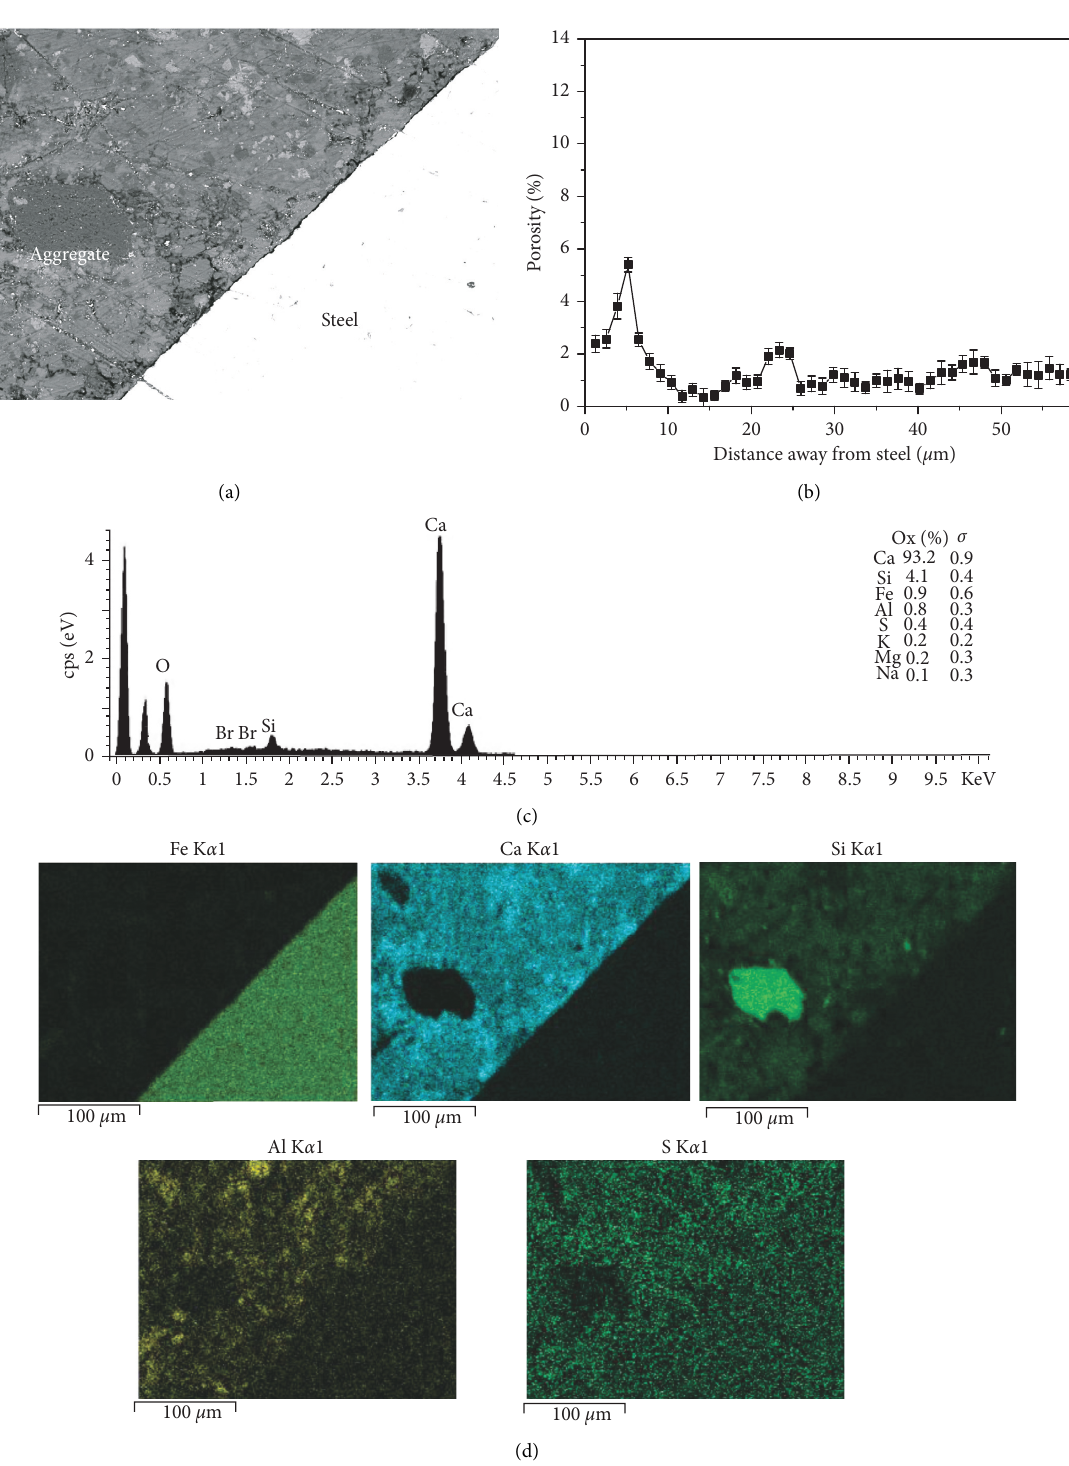
Figure 5: Microstructure of steel reinforced OPC concrete aged for 28 d: (a) microstructure of steel reinforced OPC concrete, (b) porosity at steel/concrete interface, (c) EDXA spot analysis of Point ‘2’ at ITZ, and (d) element mappings of Fe, Ca, Si, Al, and